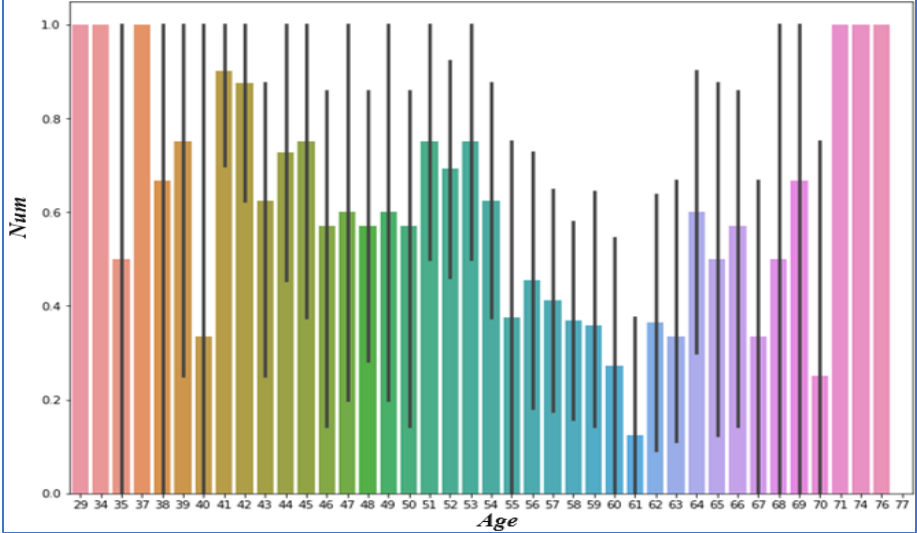
Figure 5. Heart Disease Dataset Age Statistics.